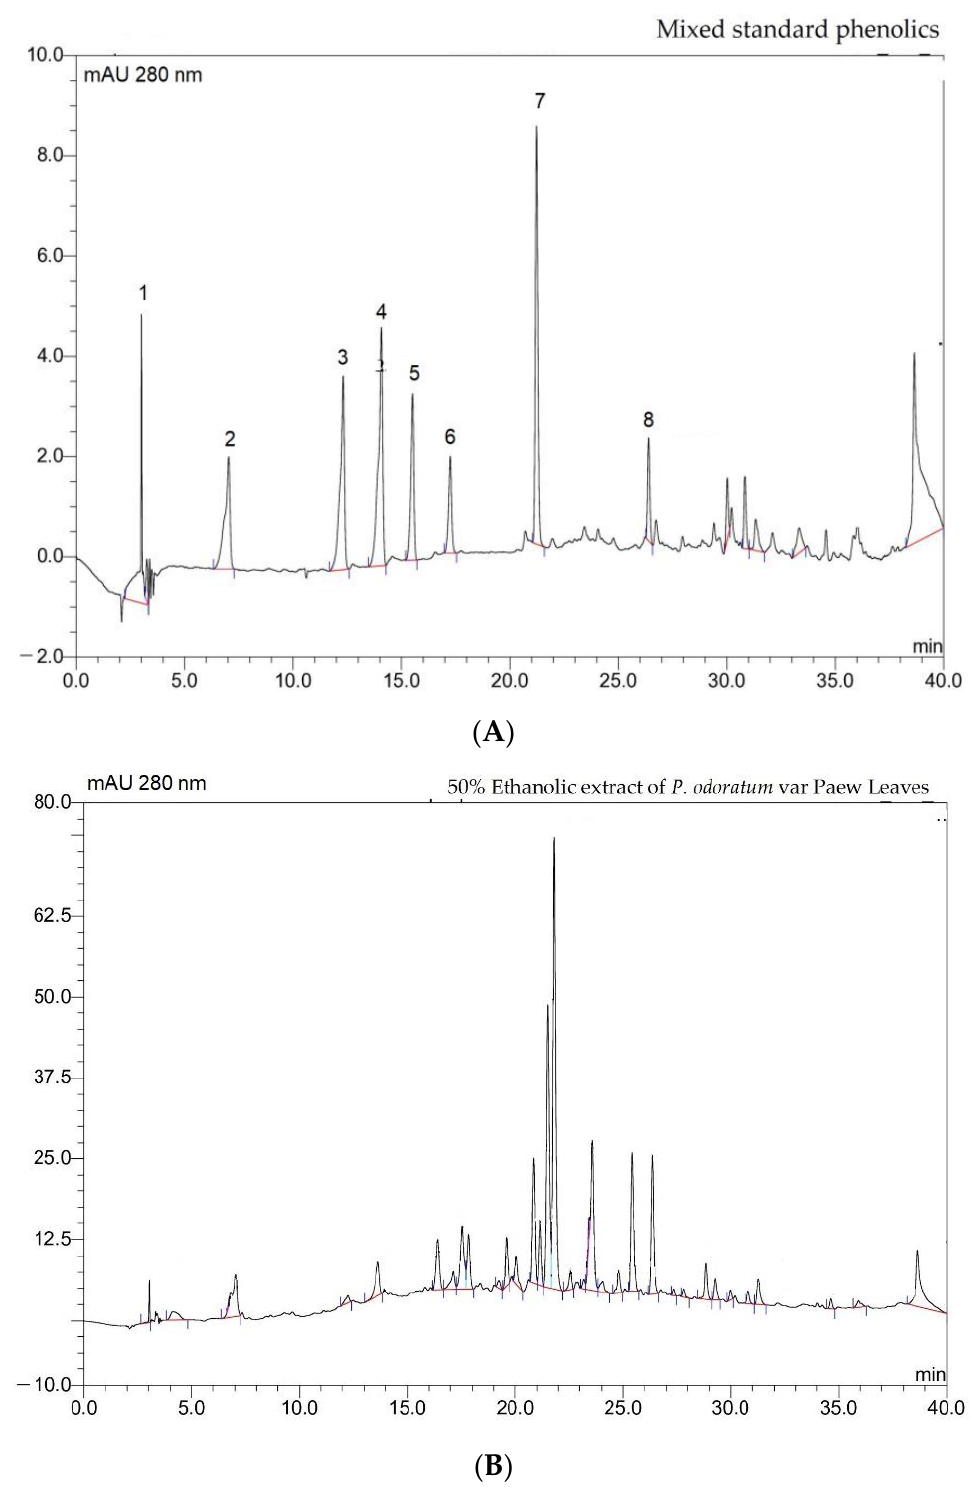
Figure 2. HPLC-DAD profile of phenolic compounds in the mixed standards that included gallic acid, catechins, epigallocatechin 3-gallate, epicatechins, epicatechin gallate, 20 µ g coumarin, quercetin ( A ) and 50% ethanolic extract of P. odoratum Lour . cv. Pakphai leaves ( B ). Table 2. HPLC-DAD analysis of the phenolic content in 50% ethanolic extracts of P. odoratum Lour . cv. Pakphai leaves. Data obtained from two separate experiments are expressed as mean ± standard errors of mean (SEM) values.